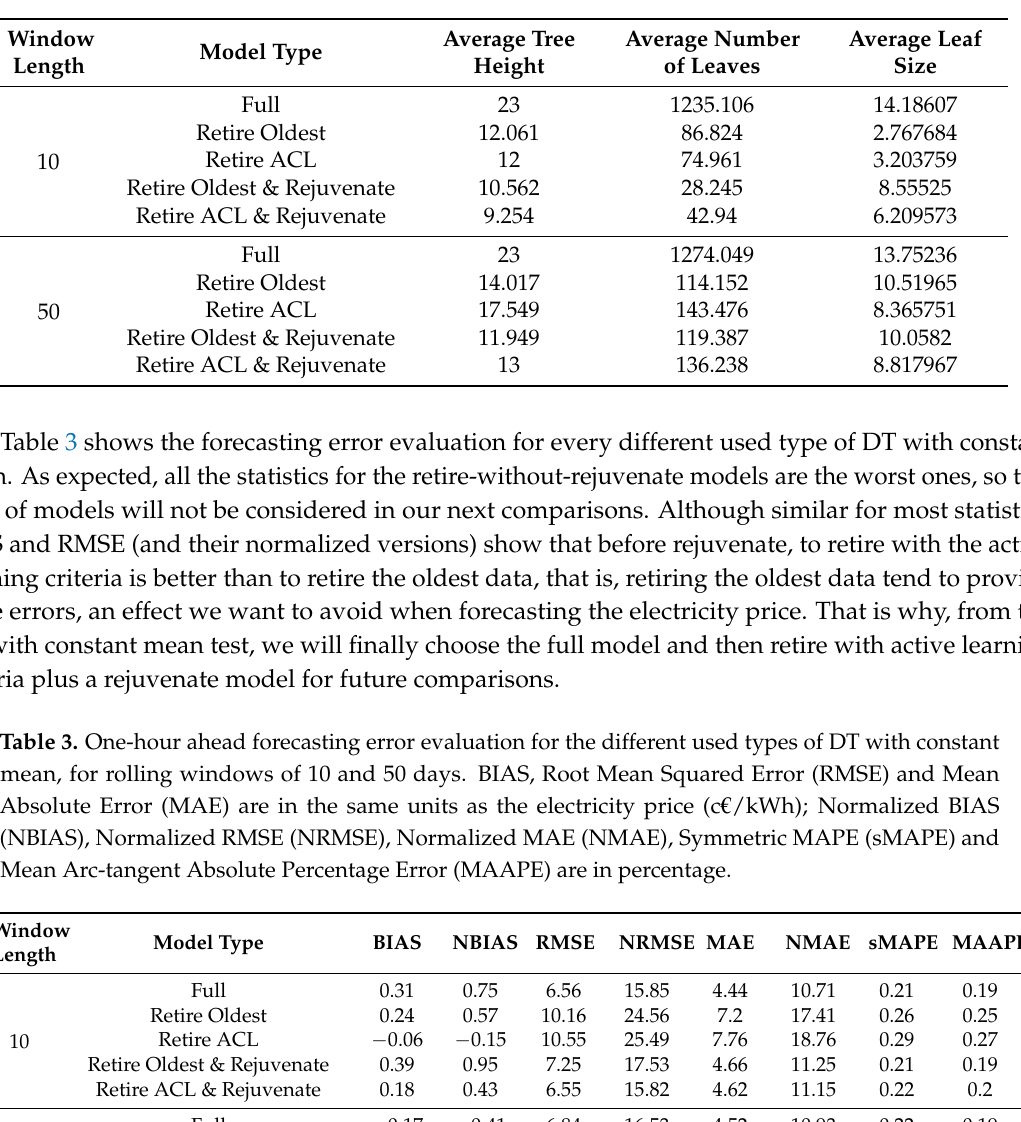
Table 2. Tree statistics for the different used types of DT with constant mean, for rolling windows of 10 and 50 days.